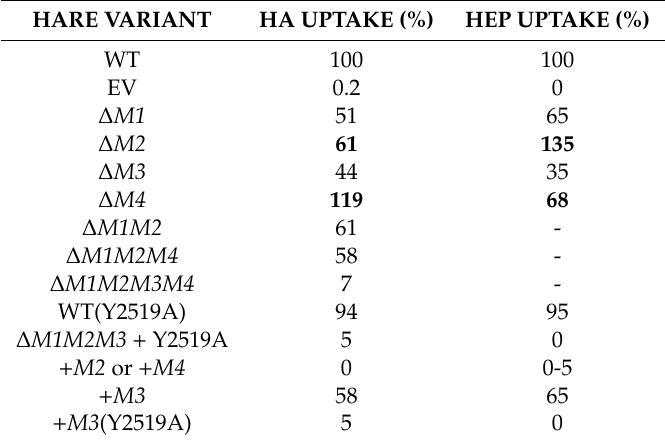
Table 1. HA or HEP endocytosis utilizes multiple HARE CD motifs. Details of the two studies are in Pandey et al. [58,59]. The organization and sequences of the four CD motifs targeting HARE to clathrin-coated pits ( M1–M4 ) are shown in Figure 5. Results in boldface ( ∆ M2 and ∆ M4 ) indicate a motif that mediates endocytosis of either one of, but not both, HA and Hep. HARE VARIANT HA UPTAKE (%) HEP UPTAKE (%) WT 100 100 EV 0.2 0 ∆ M1 51 65 ∆ M2